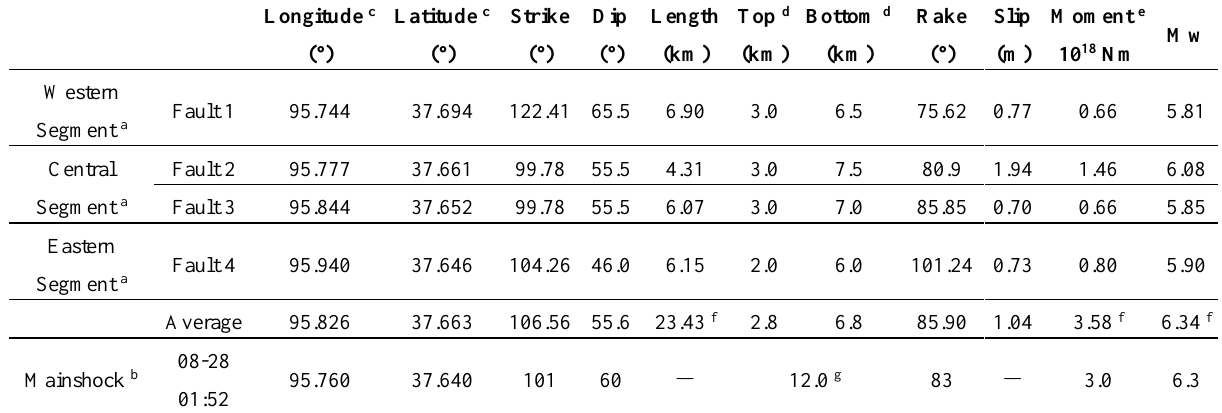
Figure 1. Regional tectonic setting of the 2009 Dachaidan Mw 6.3 earthquake. The rectangles in ( a , b ) are the spatial extents of ( b , c ), respectively. The white rectangles in ( c ) are the spatial extents of the Envisat ASAR descending Track 319 and ascending Track 455 images used in this study, with AZI and LOS referring to satellite azimuth and look direction, respectively. Thin black lines and purple lines in ( a , b ) denote the Quaternary active faults (Data from Deng et al. [3]), and the major tectonic faults (Data from Peltzer and Saucier [23]). A red beach ball with the time and magnitude labeled demonstrates the source mechanism for the main shock, while purple beach balls show the five aftershocks. Black hollow circles display the other aftershocks (Data from GCMT [2]). The epicenter of the main shock from USGS catalogue is also displayed. Table 1. Fault parameters of the 28 August 2009 Dachaidan Mw 6.3 earthquake and its five